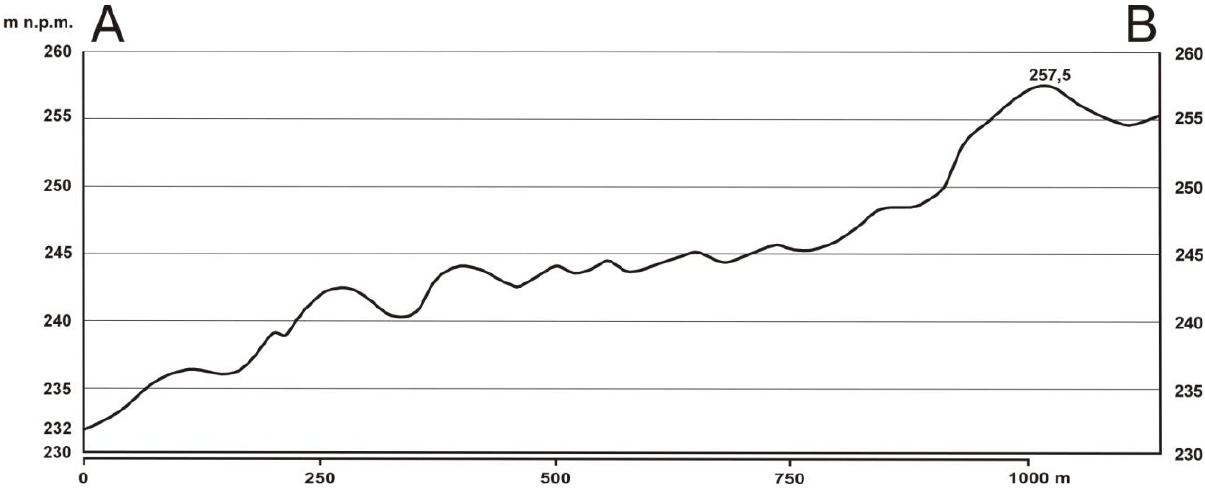
Fig. 3. Morphological profile of the depression with the glacigenic ridges in Dolisko